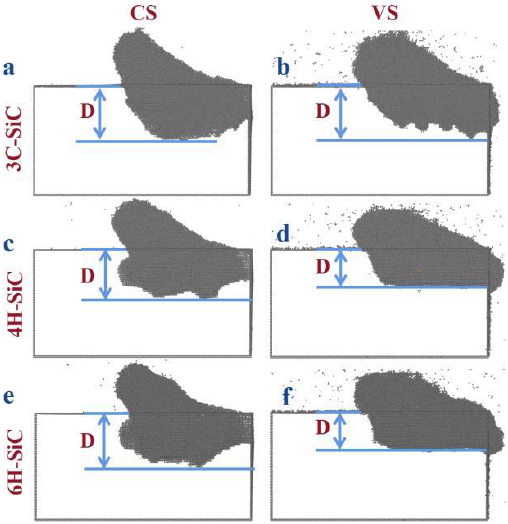
Figure 7. The amorphous atomic layer at the scratch distance of 15 nm of ( a , b ) 3C-SiC, ( c , d ) 4H-SiC and ( e , f ) 6H-SiC under CS and VS.